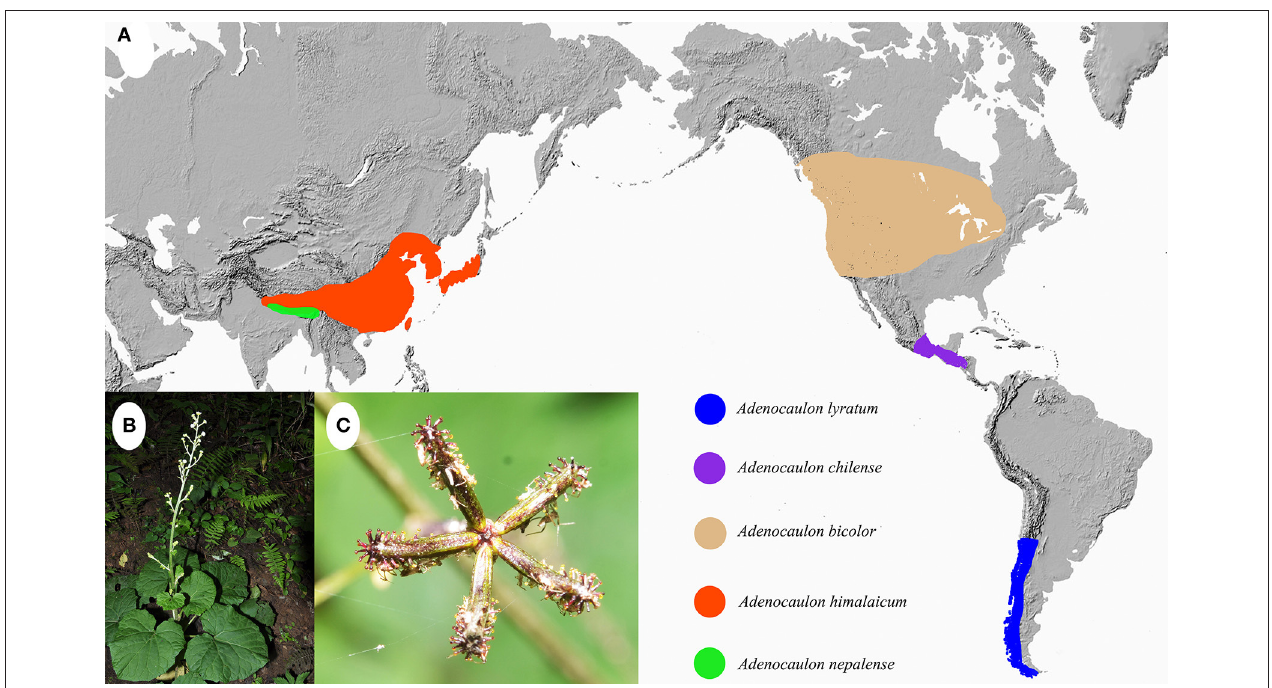
FIGURE 1 | (A) Distribution of Adenocaulon species; (B,C) , Habit (B) and achenes (C) of A. himalaicum .